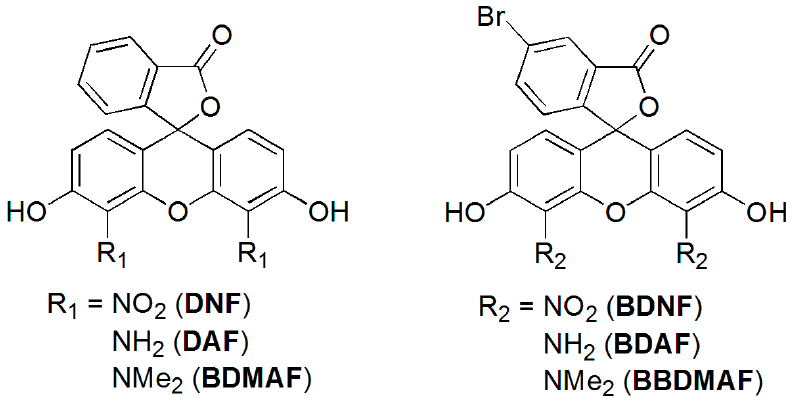
Figure 1. Fluorescein derivatives used in this study.